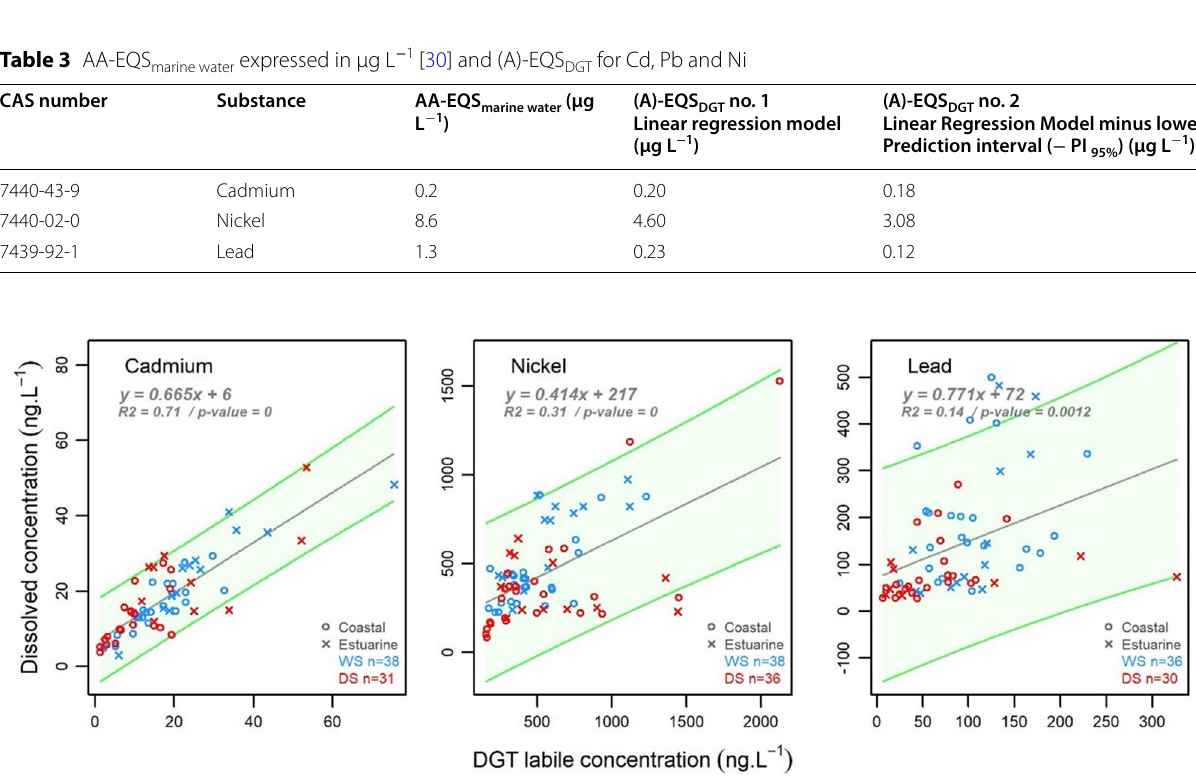
Fig. 4 Linear regression models between DGT labile and dissolved concentrations for the determination of dissolved metal concentrations from DGT measurements: ( a ) cadmium, ( b ) nickel and ( c ) lead. The regression line and its corresponding prediction intervals (PI 95%; green dashed lines and light green area) are shown. WS wet season, DS dry